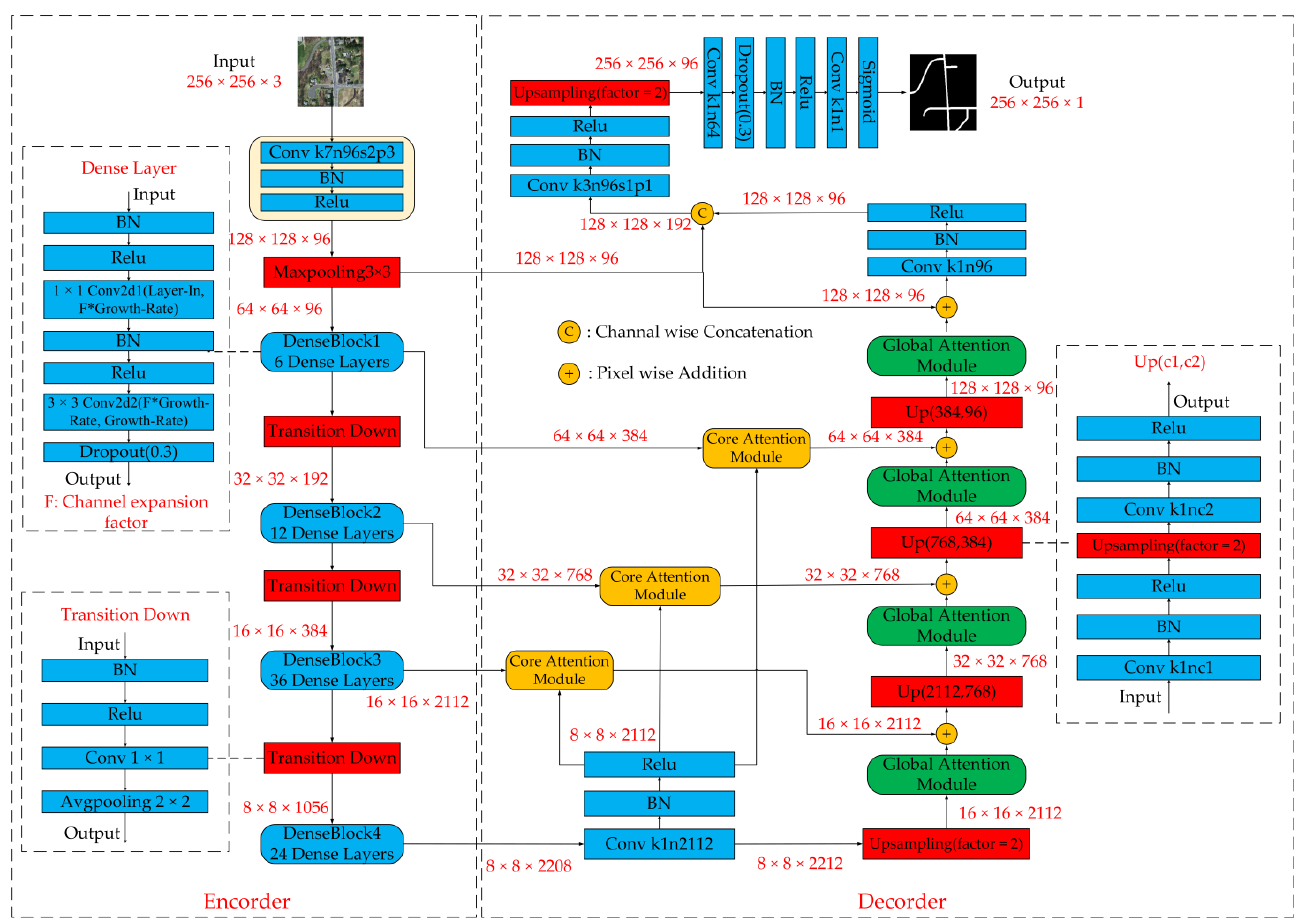
Figure 1. Architecture of CADUNet (The parameters include: k , the kernel size; n , the number of output channels; s , the stride size; p , the padding size).